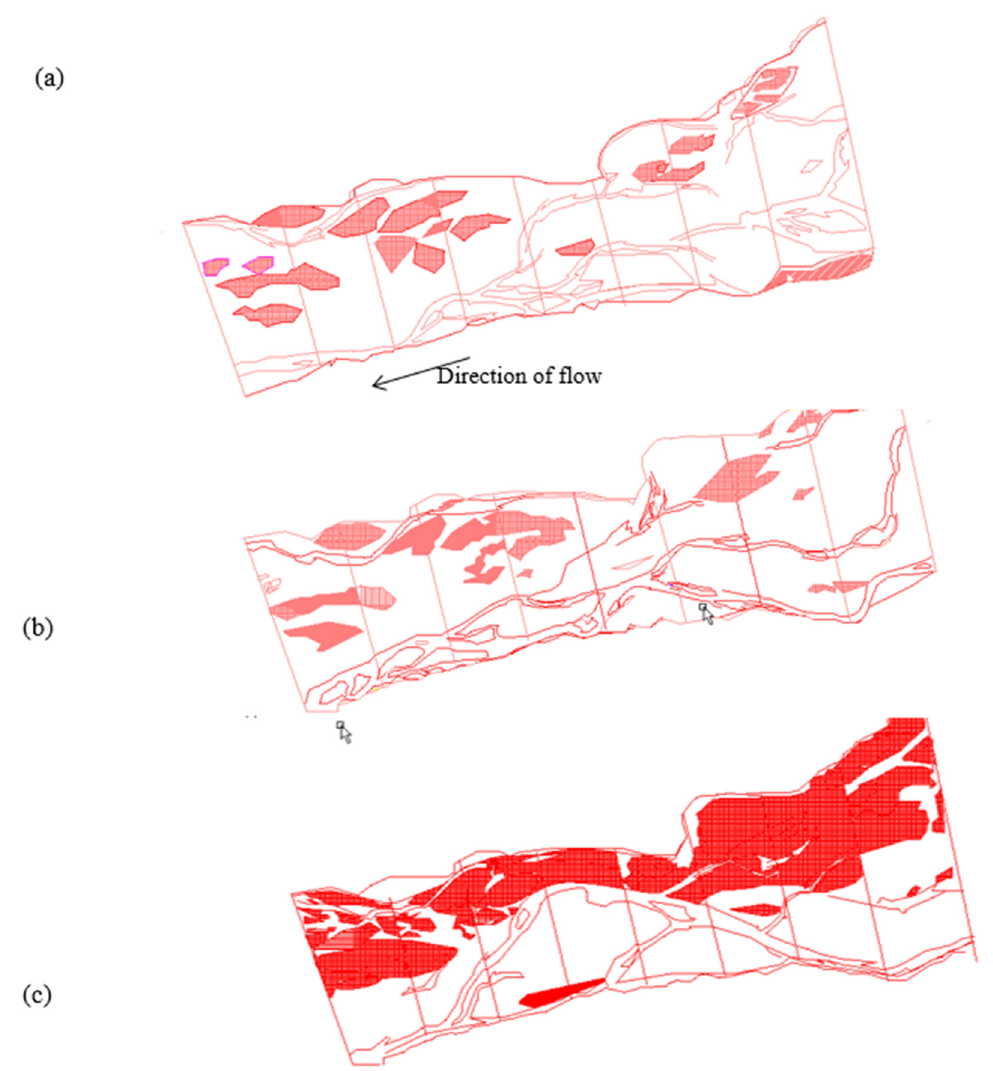
Figure 7. Digitized vegetation cover and active channels: ( a ) June 2003; ( b ) June 2005; ( c ) February 2012.